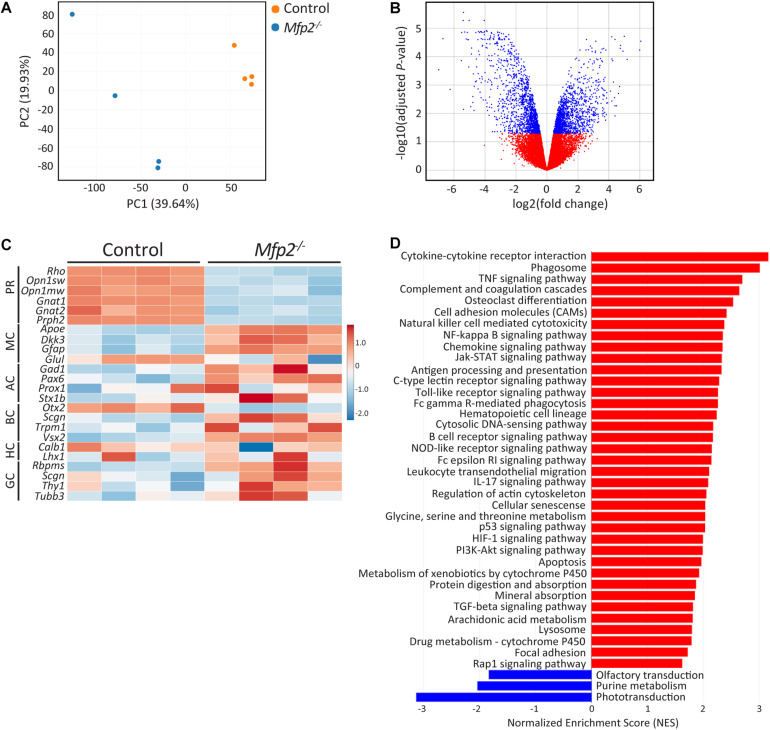
Distinct transcriptomic profile of Mfp2–/– retinas. (A) Principal component analysis (PCA) and (B) volcano plot of the differential expression analysis reveal a different transcriptomic signature of 3 weeks-old Mfp2–/– retinas. Blue and red dots in (B) represent differentially expressed and unchanged genes, respectively. (C) Heat map showing the expression of selected cell type specific genes. (D) GSEA reveals a major downregulation in the phototransduction pathway and a major upregulation in cell death and inflammation related pathways. Blue and red bars represent down- and upregulated pathways, respectively (n = 4 per genotype) PR, photoreceptors; MC, Müller cells; AC, amacrine cells; BC, bipolar cells; HC, horizontal cells; GC, ganglion cells.